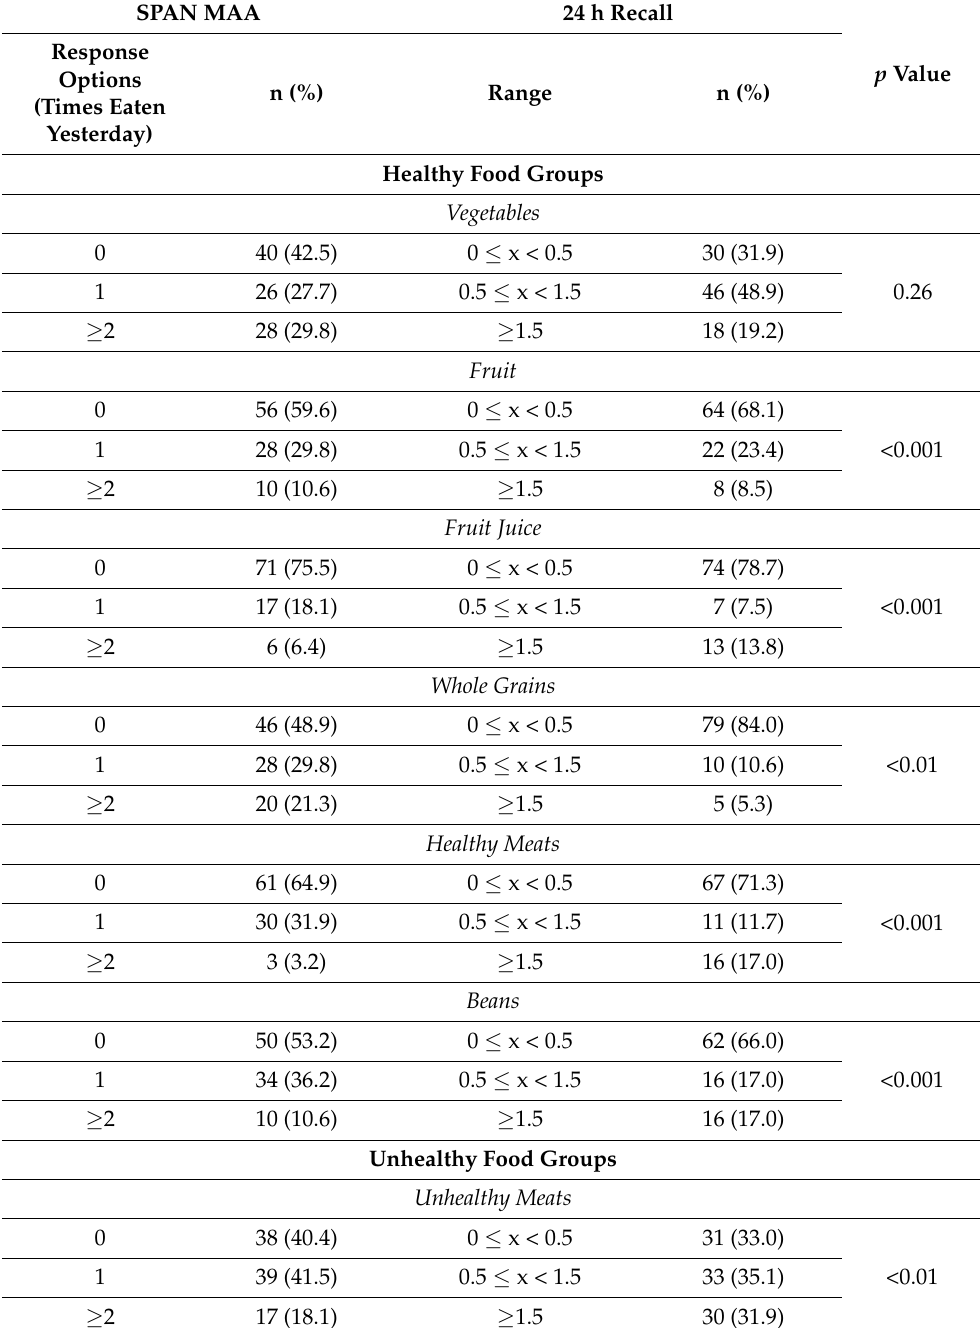
Table 3. Comparison of reported food consumption by category as collected by the SPAN MAA and 24 h recall (n =